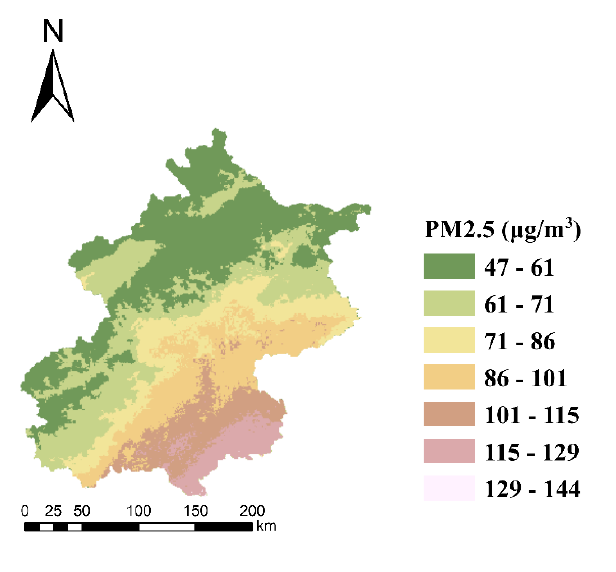
Figure 3. Estimated average PM2.5 concentration distribution in autumn and winter of Beijing.